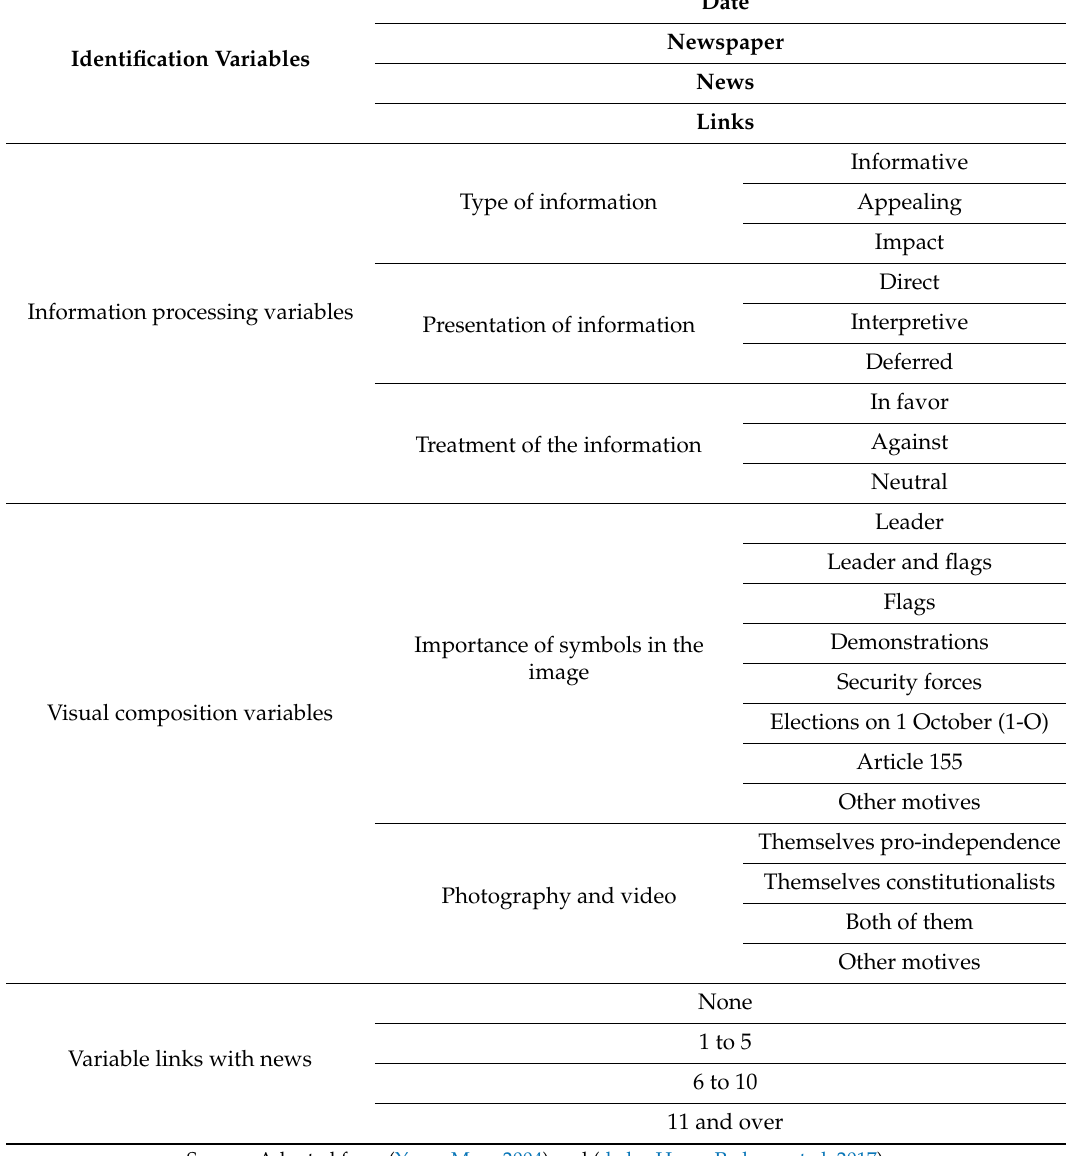
Table 3. Evaluation